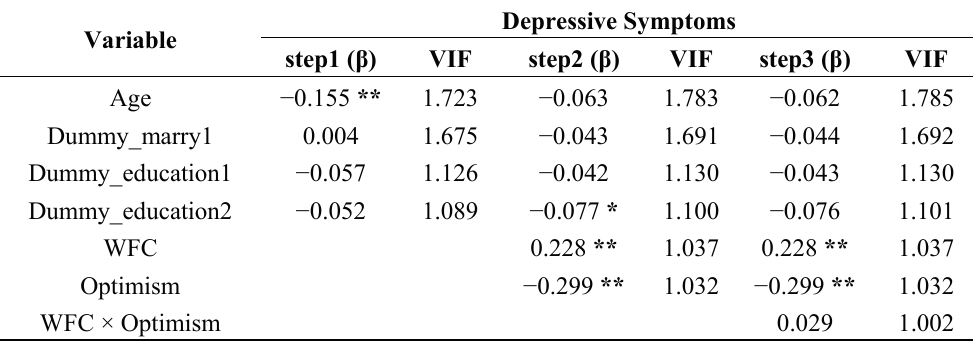
Table 8. WFC as the independent variable and optimism as the moderator in the regression